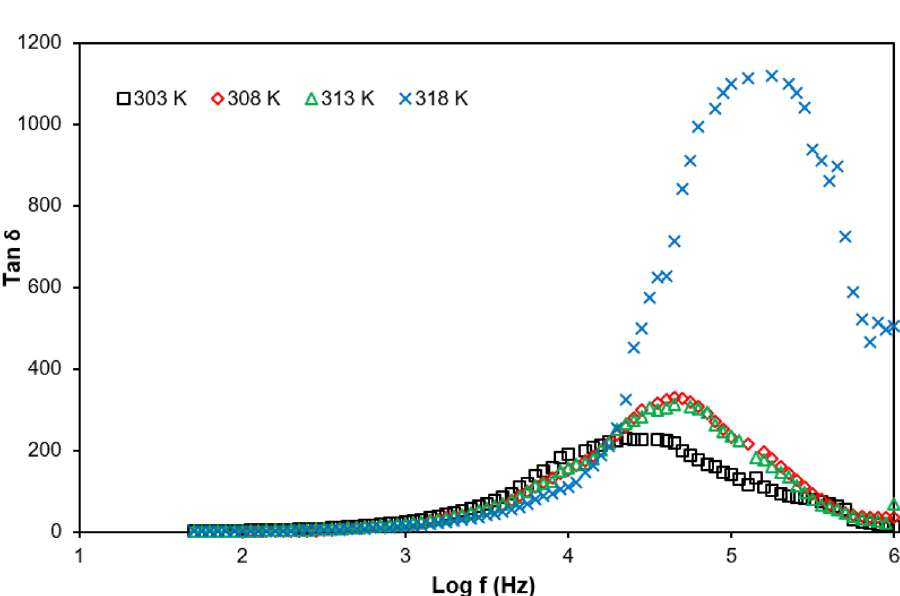
Figure 13. Frequency dependence of tan δ for PUA-30 wt% TBAI-I 2 GPE at selected temperatures. Shifting the peak towards higher frequency indicated the increase of ionic